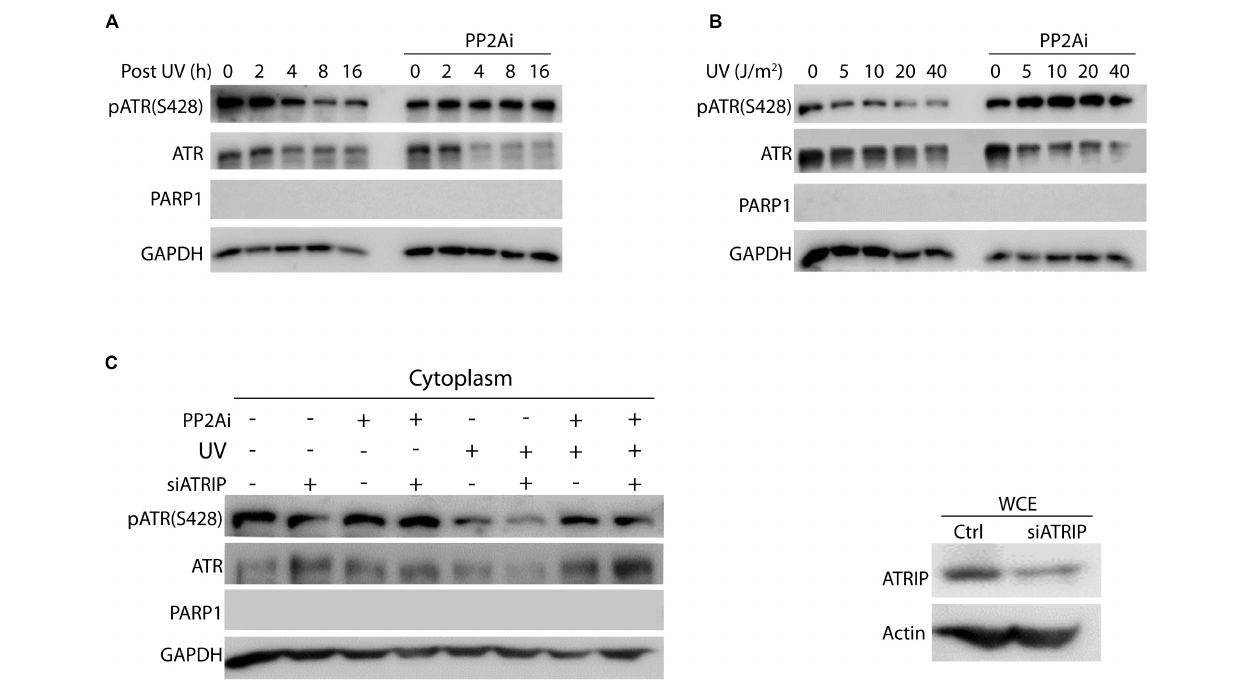
FIGURE 2 | Protein phosphatase 2A (PP2A) dephosphorylates cytoplasmic pATR (S428) in a UV dose- and recovery time-dependent manner and is independent of ATRIP. (A) Cytoplasmic pATR (S428) dephosphorylation by PP2A is dependent on post-irradiation recovery time in A549 cells. The WB shows that the level of ATR phosphorylation at S428 depends on the recovery time following UV irradiation at 40 J/m 2 . PP2A inhibitor treatment (PP2Ai) abolishes this dephosphorylation at all recovery times. (B) Cytoplasmic pATR (S428) dephosphorylation by PP2A is UV dose dependent and is attenuated with PP2A inhibitor treatment of A549 cells. Control A549 cells show a reduction in the level of pATR (S428) that is dependent on the dose of UV irradiation used, but retain their level of pATR (S428). (C) A549 cells, depleted of ATRIP by siRNA knockdown, were divided into two groups with one treated with PP2A inhibitor and the other left as a control. WB assay shows that this ATRIP knockdown does not affect PP2A’s dephosphorylation of pATR (S428) in the cytoplasm of A549 cells. The right panel shows the efficiency of the ATRIP